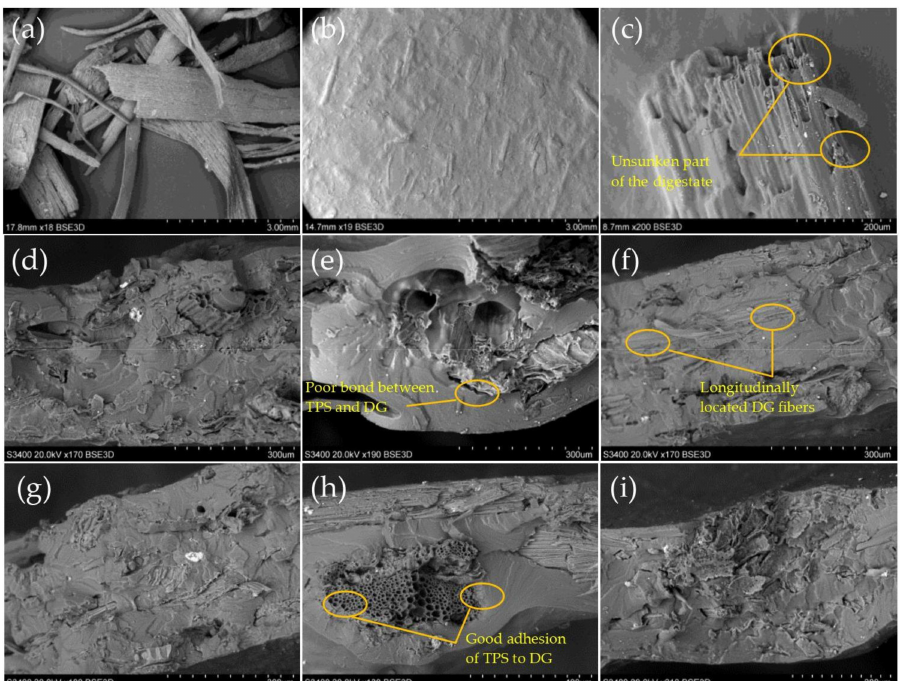
Figure 5. SEM microscopic images of digestate used in studies; ( a ) dried raw digestate; ( b ) exemplary digestate particle blended into TPS matrix; ( c ) surface view of composite obtained, 05 mm particles; ( d ) DG14(01); ( e ) DG14(05); ( f ) DG7(01); ( g ) DG14(01)U; ( h ) DG14(05)U; ( i )